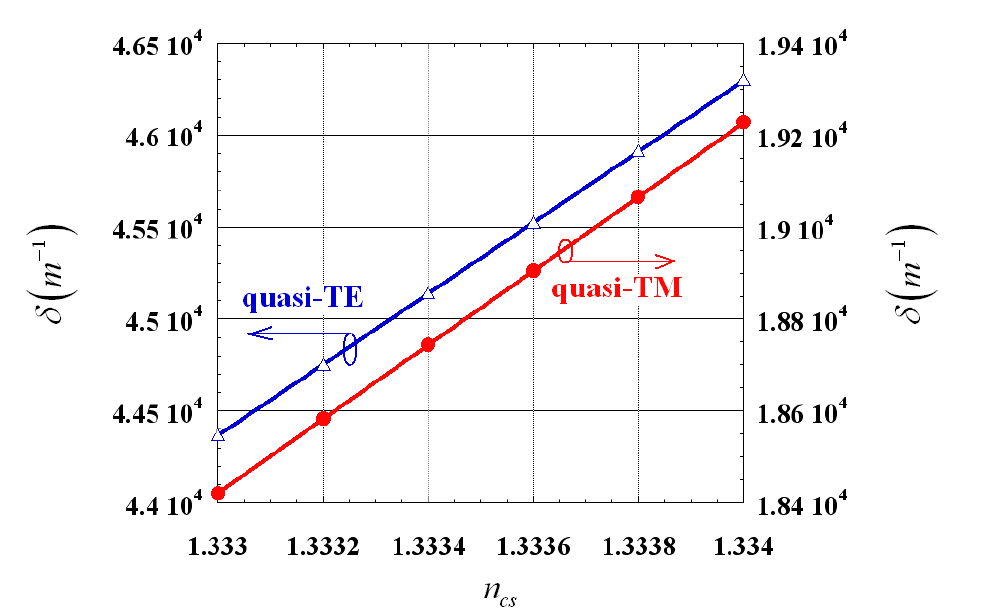
for quasi-TE and quasi-TM cs